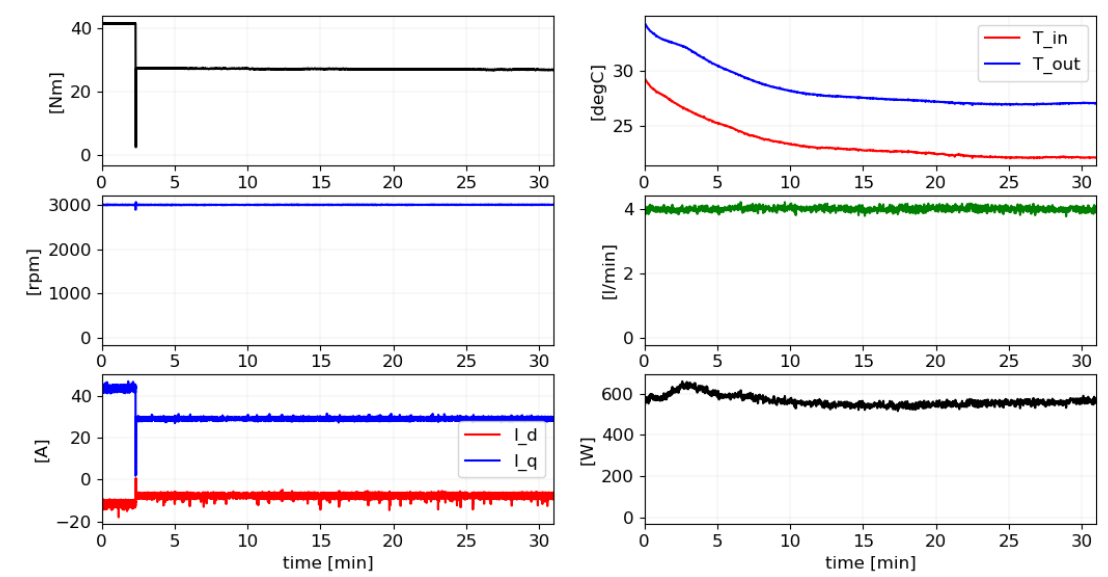
Figure 17. Calorimetric run at 3000 rpm and 30 A RMS. The plots are showing: top left output torque, top right oil inlet and outlet temperature, middle left mechanical speed, middle right oil flow rate, bottom left d-axis and q-axis currents, bottom right calorimetric